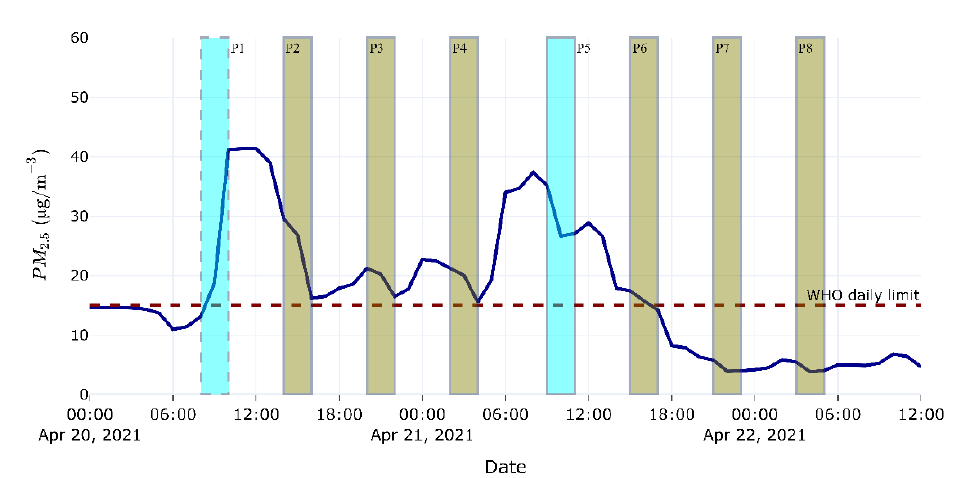
Figure 10. Time series evolution of PM 2.5 mass concentration at our sampling site. Colored rectangles represent the TRAPS sampling periods, where P1 and P5 (cyan) are the analyzed samples whose results are discussed in the paper.